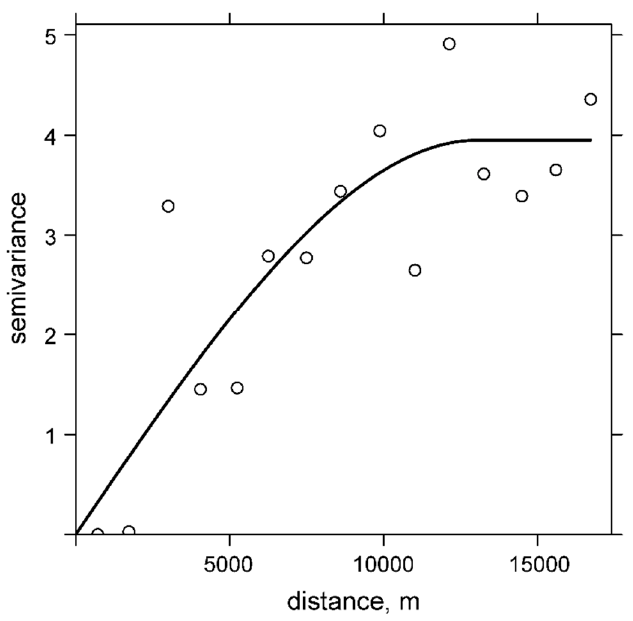
( b ) Figure 4. ( a ) Sample plot showing a trend surface of the QPESUMS rainfall distribution, and ( b ) sample plot of the residual surface of rainfall variation, based on radar data from Typhoon Morakot